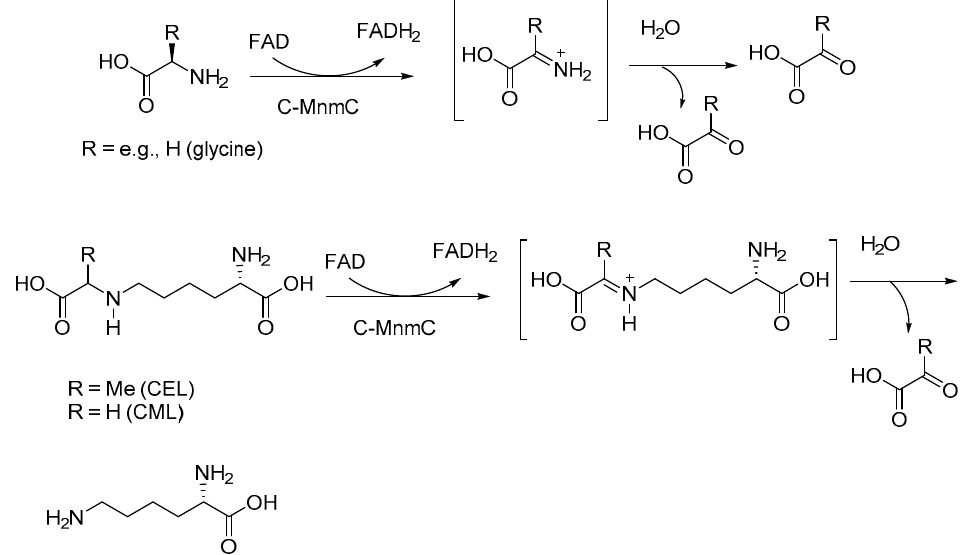
Figure 2. MnmC-catalyzed oxidative deamination of α -amino acids and reversal of AGE modifica- tions of CML and CEL.